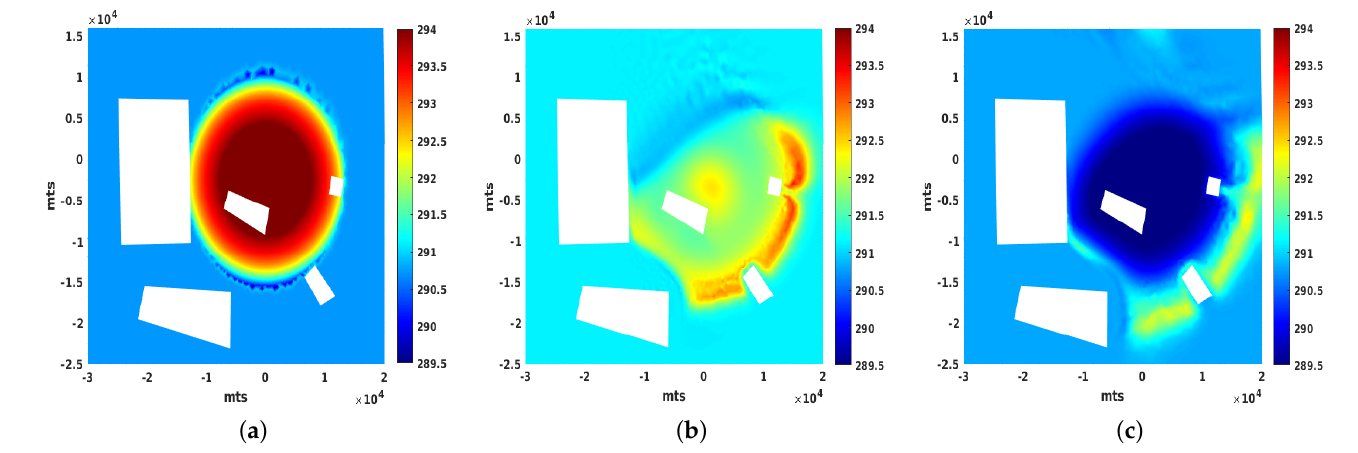
Figure 8. Dynamics of the transport of warmer mass air during wind gusts. ( a ) θ a before wind blows at 13 h. ( b ) θ a an in-between time period of blowing wind. ( c ) θ a final state at 17